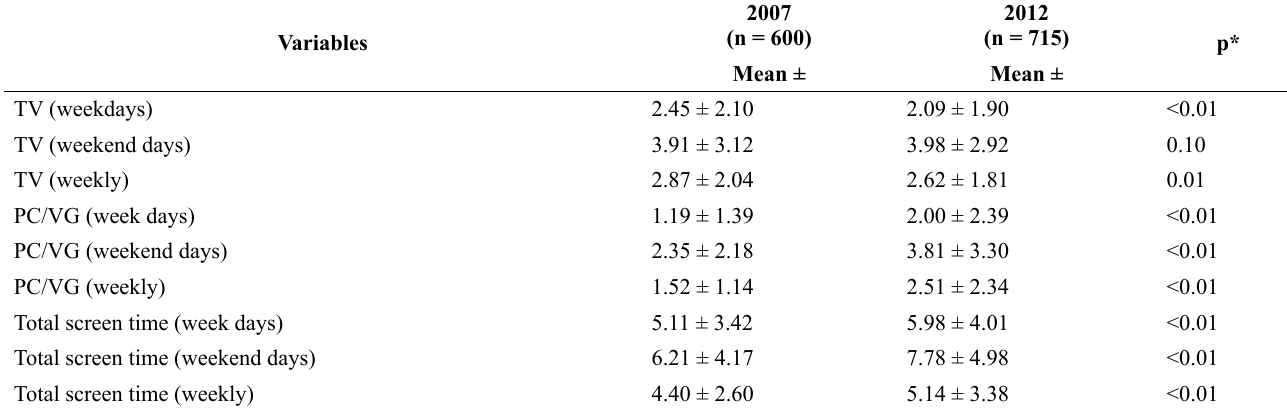
Table 2. Mean and standard deviation of the time spent on screen electronic devices (in hours) during the weekdays, weekends, and weekly total of high school students of the public school network of Caruaru, PE, Brazil - 2007 and 2012.